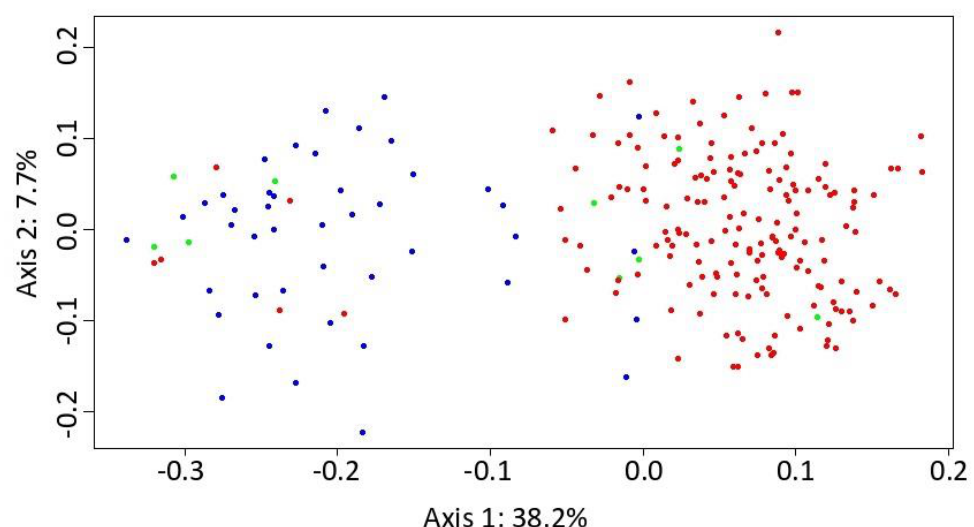
Figure 3. Principal coordinate analysis (PCoA) carried out in the POLYSAT package in R for Alnus glutinosa s. str. (blue marks), A . rohlenae (red mark) and putative triploid hybrid (green mark). The percentage of variance explained by each axis is provided in the figure.